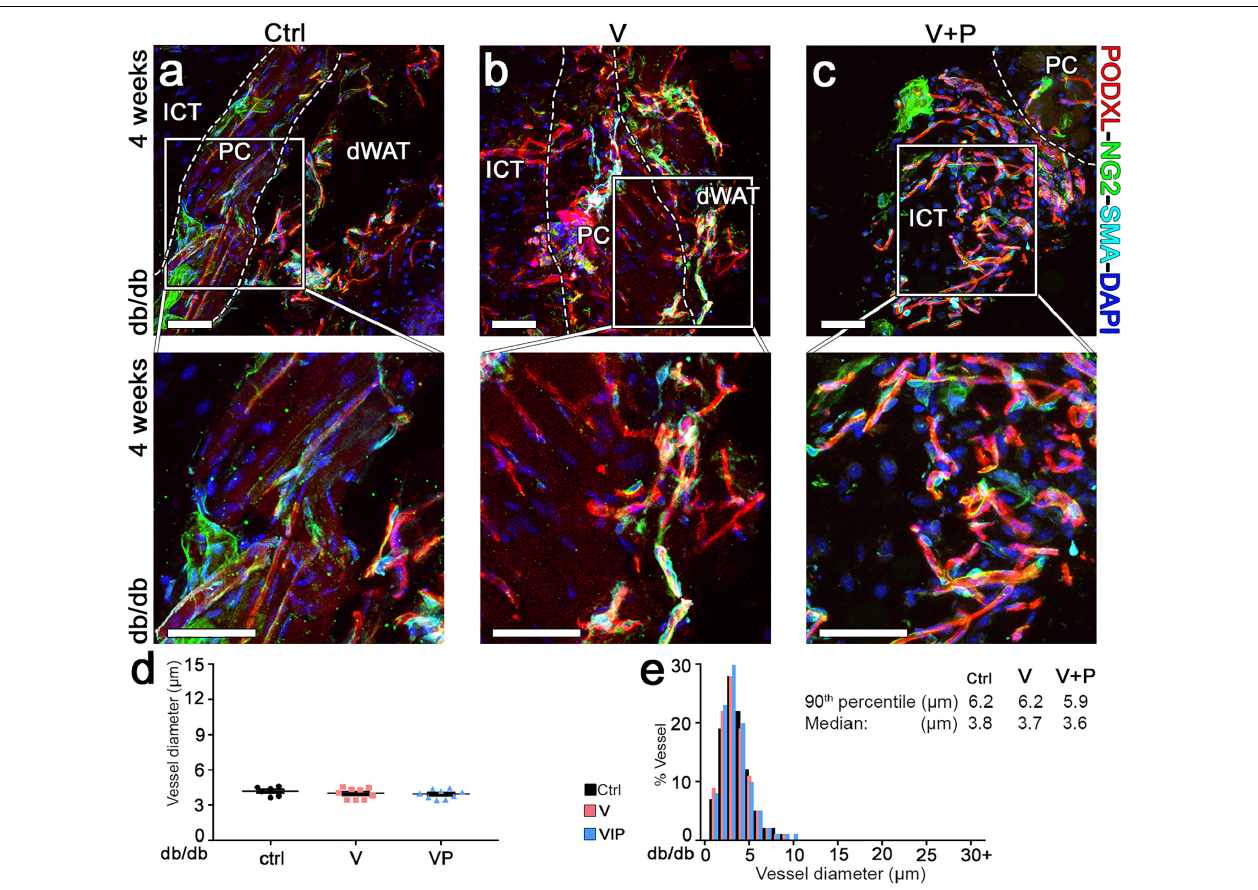
FIGURE 6 | Long-term maturation and size of angiogenic vessels in diabetic skin. (a–c) Vascular morphology was analyzed 4 weeks after implantation of V, VP or control (ctrl) empty fibrin gels, by immunofluorescence staining for podocalyxin (endothelial cells, red), NG2 (pericytes, green), α -SMA (smooth muscle cells, cyan), and DAPI (nuclei, blue). The lower panels show higher-magnification views of the areas marked by the white squares in the top panels. Size bars = 50 µ m in all panels; dWAT, dermal adipose white tissue; PC, panniculus carnosus; ICT, interstitial connective tissue. (d,e) Vessel diameters (in µ m) were quantified and results are shown as mean values of each sample ± SEM (d) and as the distribution of vessel diameters over 1- µ m intervals (e) ; n = 6–9